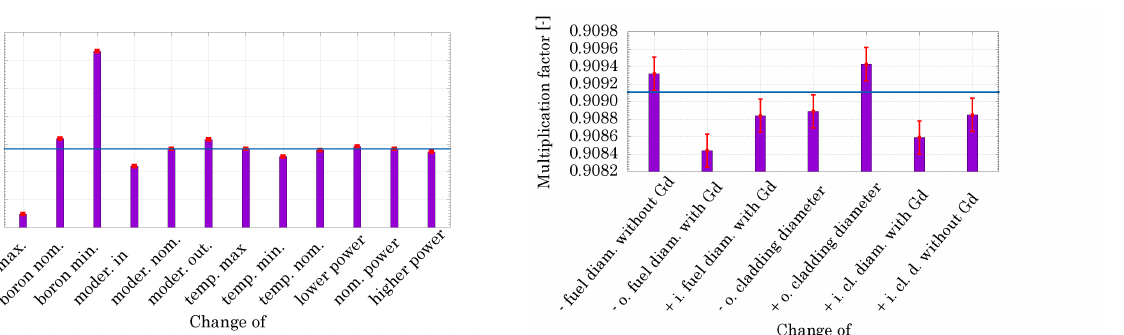
Figure 15. Effect of uncertainties of geometry on multiplication